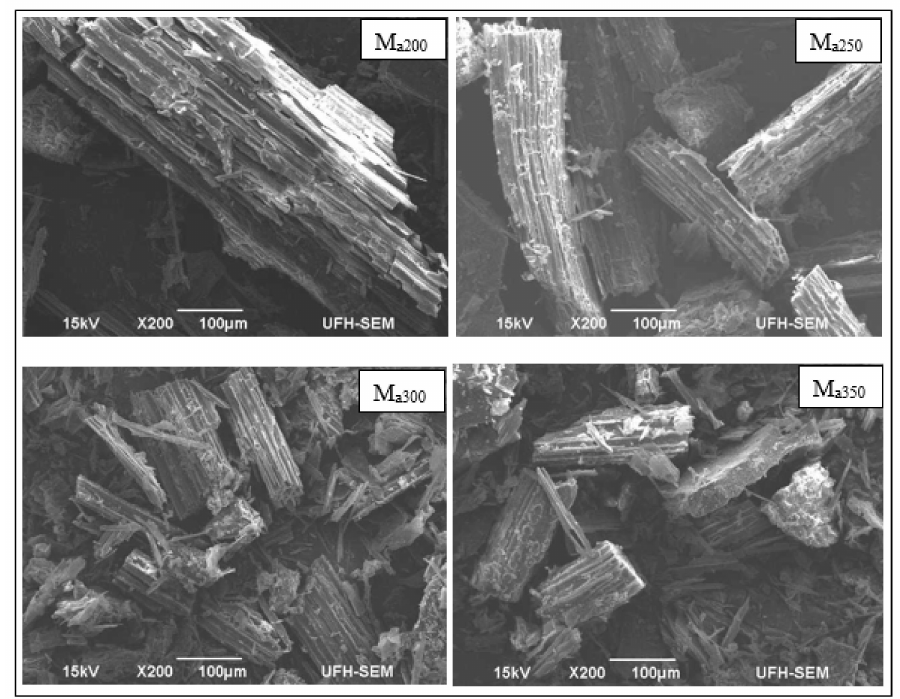
Figure 3. SEM images of 50% SS to 50% BG blended ratio of torrefied SS and BG.